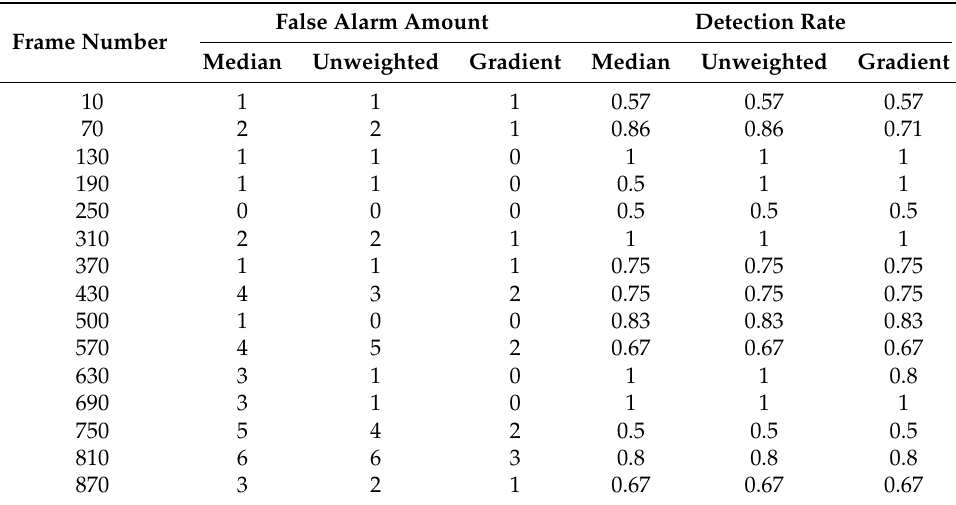
Table 1. Statistical results of false alarm amount and detection rate of different false alarm reduction methods. ’Median’ represents median filtering, ’Unweighted’ represents unweighted edge detection case and ’Gradient’ represents gradient-weighted case